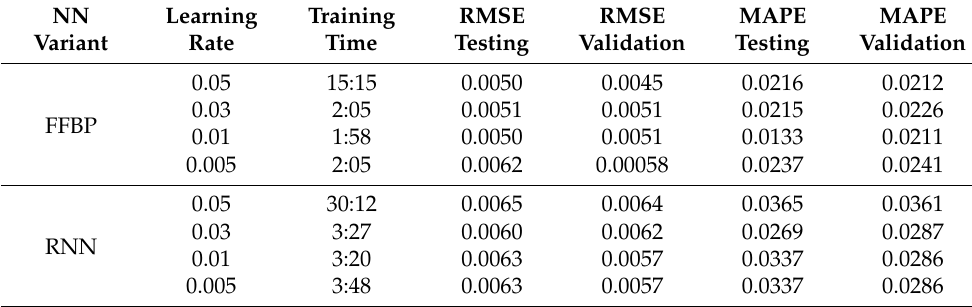
Figure 7. Testing error between estimated and target values for case 4. Table 7. Training and testing results of FFBPNN and RNN for case